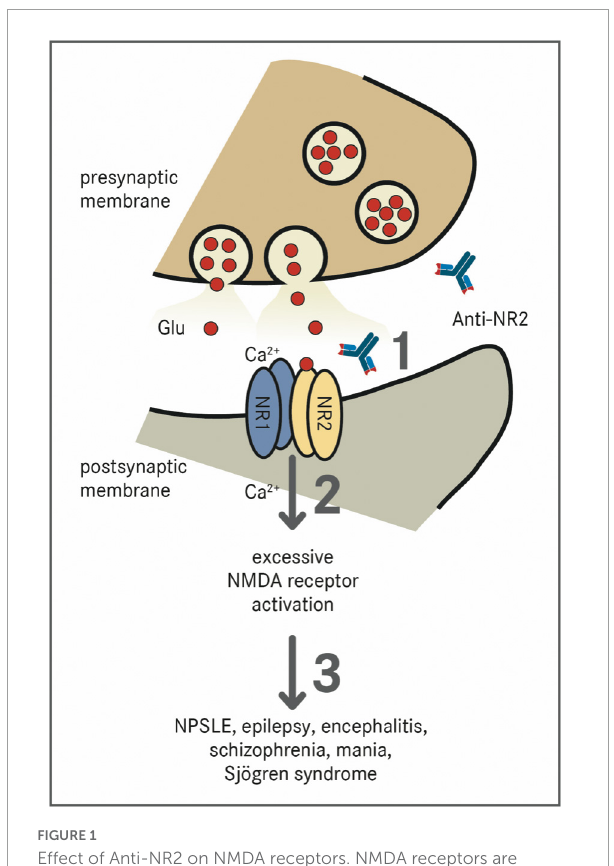
FIGURE1 Effect of Anti-NR2 on NMDA receptors. NMDA receptors are tetramers which are composed of two NR1 subunits and two out of four NR2 (A–D) subunits (38). The receptor is physiologically activated by the binding of glutamate (Glu) to the NR2 subunit and glycine to the NR1 subunit, which results in a voltage-dependent excitatory influx of Na + -ions and Ca 2 + -ions into the cell (39). (1) Pathologically, Anti-NR2 antibodies (Anti-NR2) bind to the extracellular domains of the NR2A and/or NR2B subunit of the NMDA receptor (40). (2) These antibodies act as positive allosteric modulators with a much higher sensitivity to the NR2A subunit leading to an excessive activation of the NMDA receptor (42). (3) The presence of Anti-NR2 is associated with the diseases such as NPSLE, epilepsy, encephalitis, schizophrenia, mania, or Sjögren syndrome